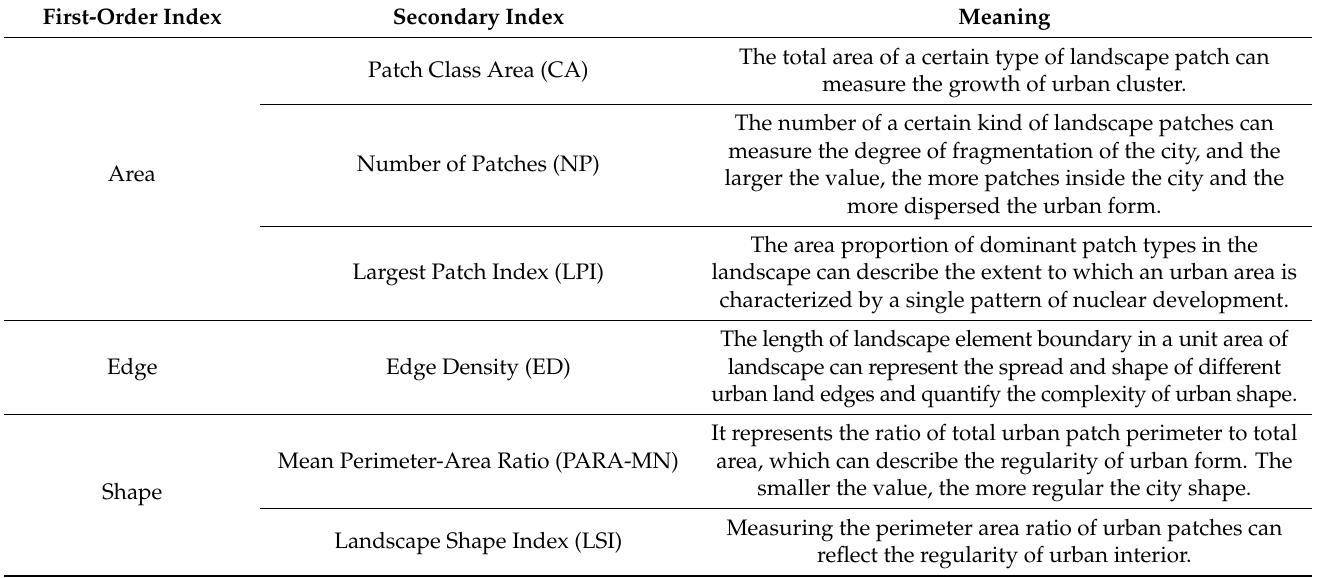
Table 2. Landscape spatial index